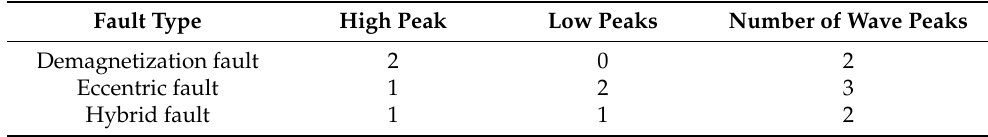
Table 3. Waveform comparison of the residual values of the MSCS for different